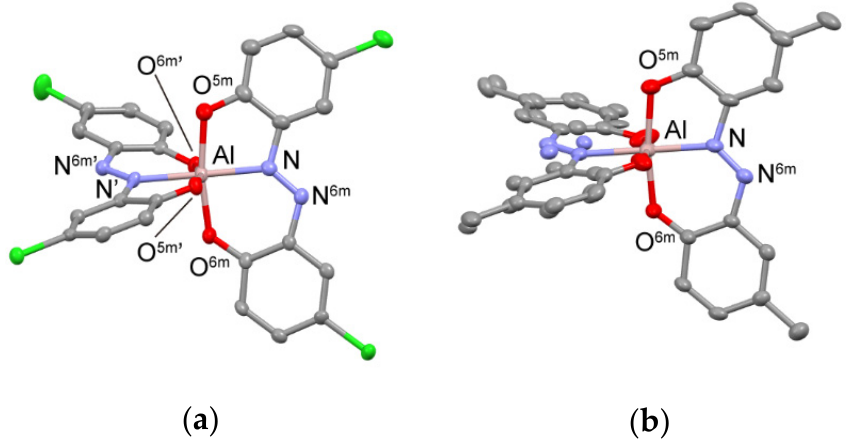
Figure 2. ORTEP drawings with a 50% probability. ( a ) One of the [Al III (L1 Me2 ) 2 ] anions in 1-Cl 2 ; ( b ) The [Al III (L1 Me2 ) 2 ] anion in 1-Me 2 . The atoms of a minor disordered ligand are shown without bond bars. Table 1. Coordination geometries and bonding parameters of the metal complexes with azp ligands.